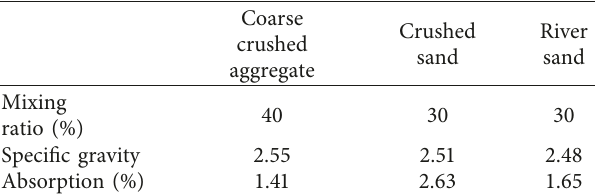
Figure 1: Particle size distribution of cement, metakaolin, and calcite. Table 2: Specific gravity, water absorption capacity, and pro- portions of